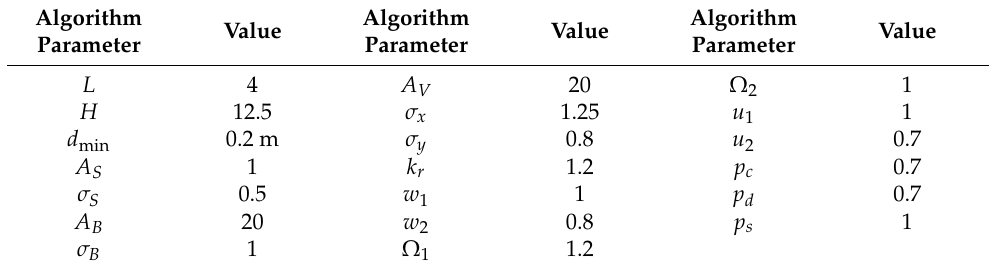
Table 4. Value of algorithm